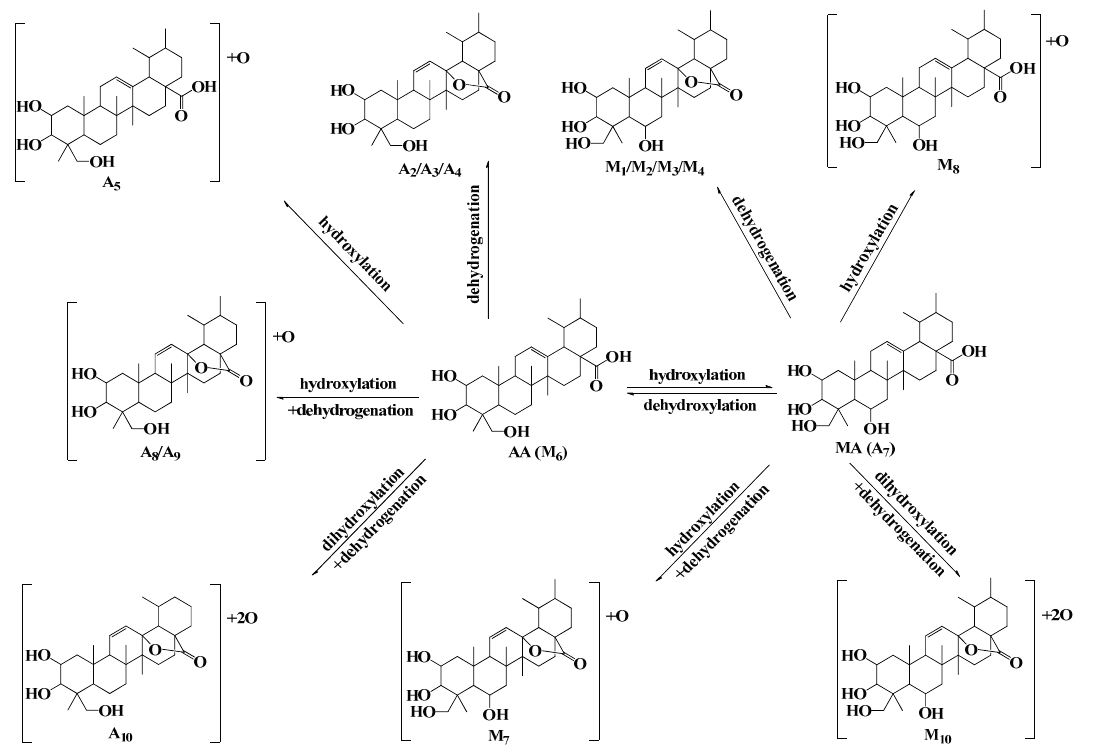
Figure 6. The main putative metabolites and proposed metabolic pathways of AA and MA in